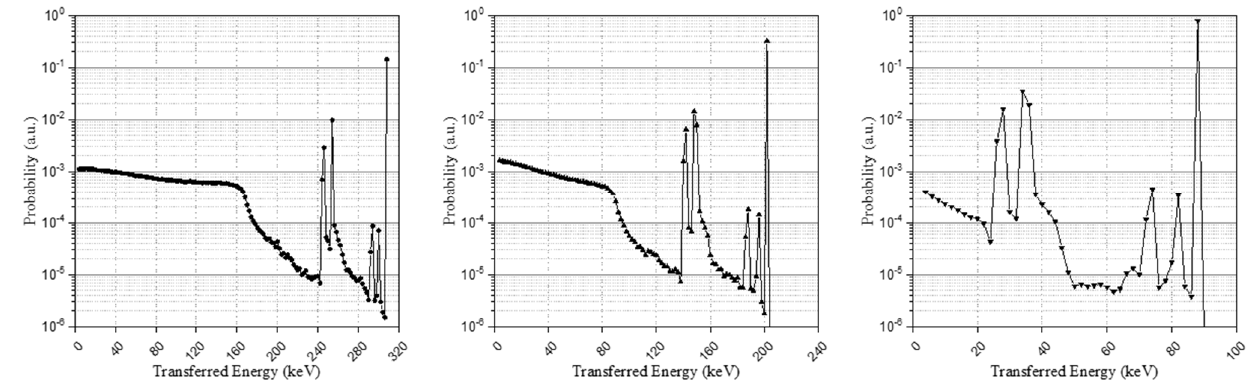
Figure 3. Isomer transition I, II, and III spectra in the LYSO crystal with a size of 3 × 3 × 20 mm 3.